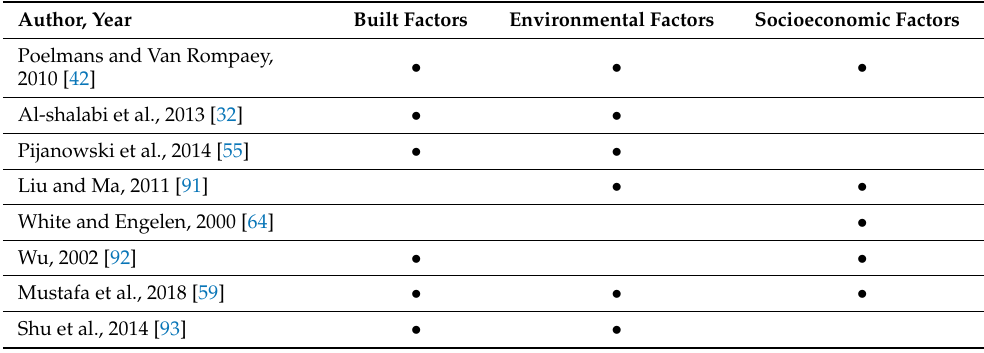
Table 2. Lineage of works of literature that define driving forces.